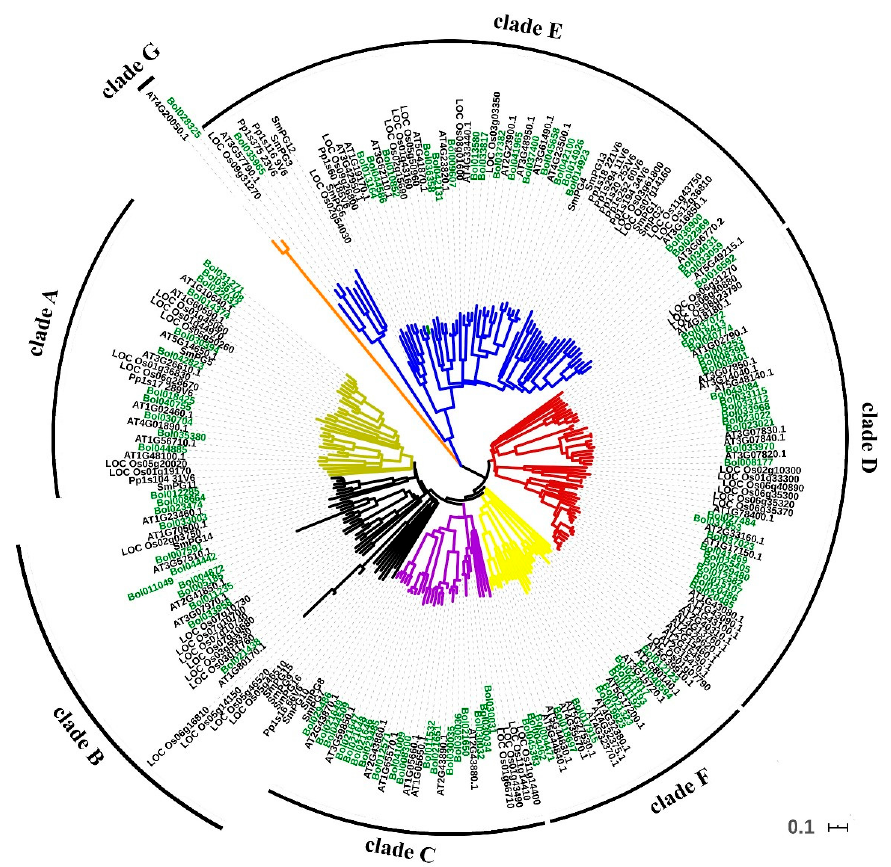
Figure 1. Phylogenetic tree of the 238 polygalacturonases (PGs) from five land plant species. The tree was constructed by using the neighbor-joining (NJ) method. The bar indicates the relative divergence of the sequences